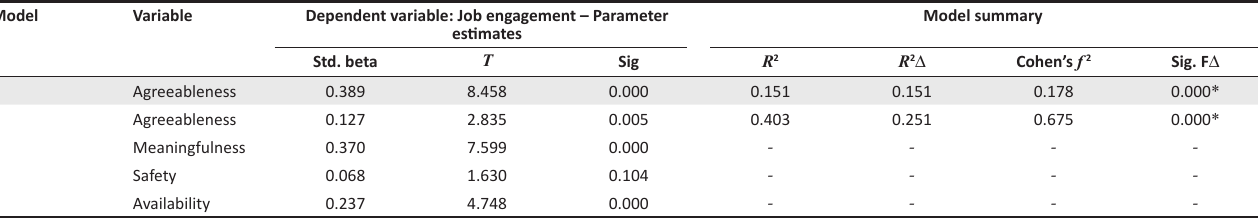
TABLE 7 : Hierarchical multiple regression analyses testing agreeableness and psychological conditions constructs in the prediction of job engagement. Model